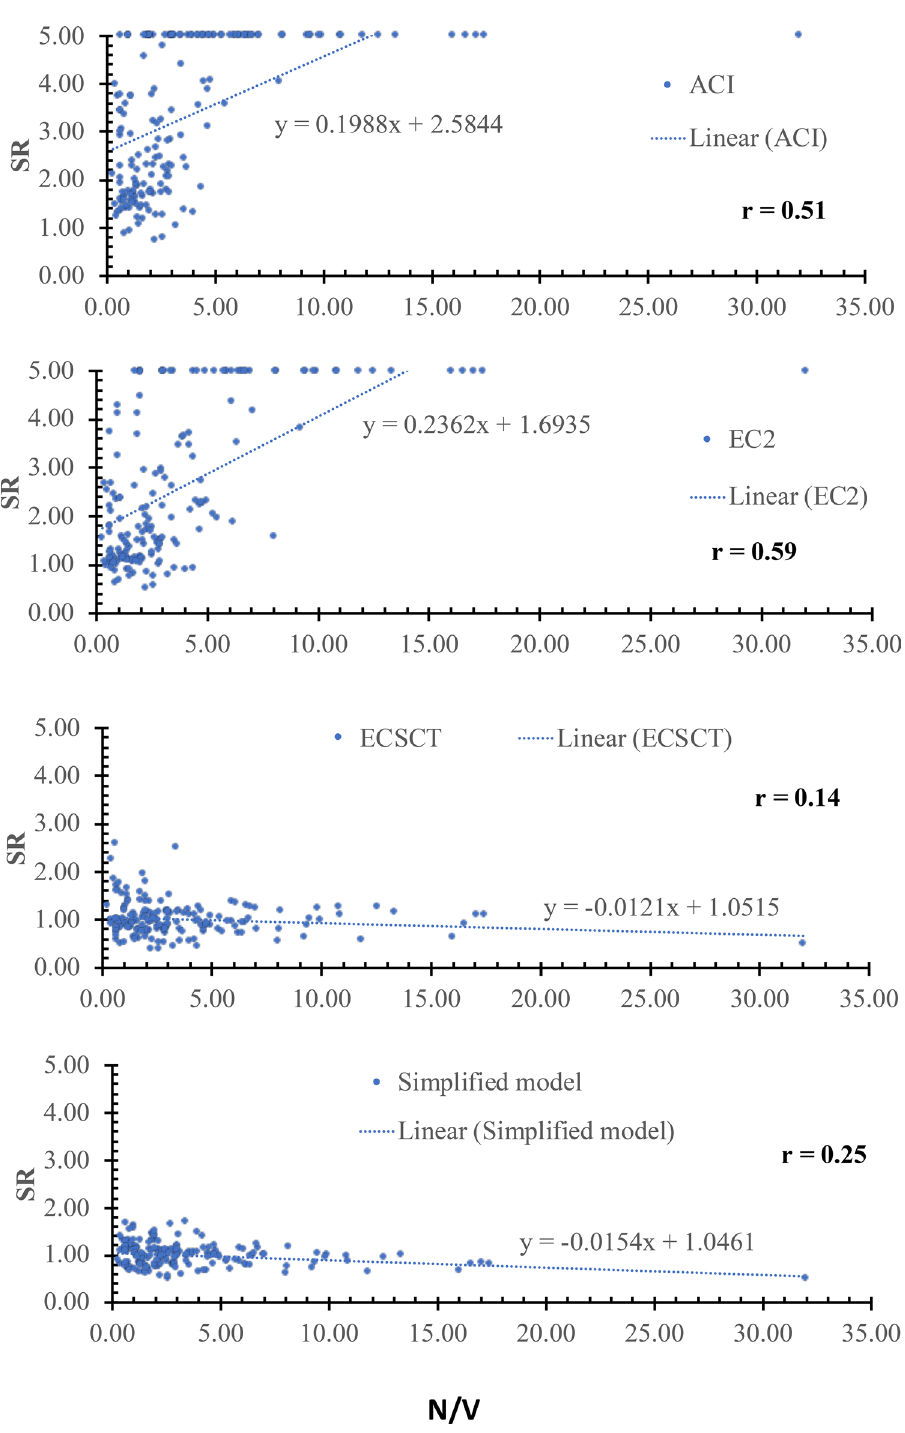
Figure 9. SR using various methods versus the N / V